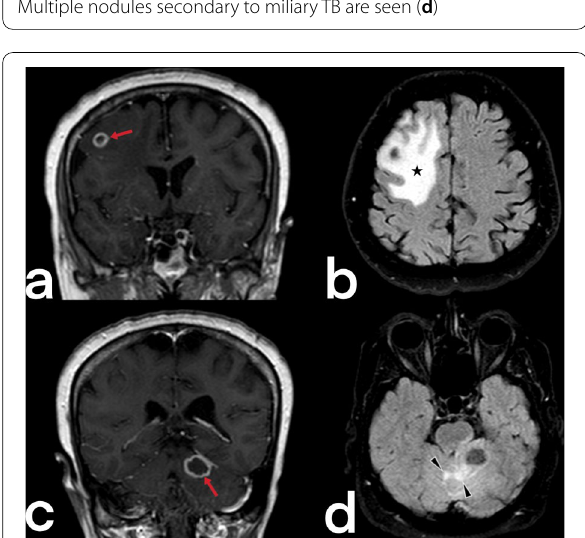
Fig. 4 MR images of a 63-year-old female with central nervous system TB. Focal lesions (arrows) with rim-like enhancement are seen (tuberculoma) on contrast-enhanced coronal T1 weighted images ( a, c ). Perilesional increased signals (asterisk and arrowheads) due to vasogenic edema are noted on axial FLAIR images ( b, d